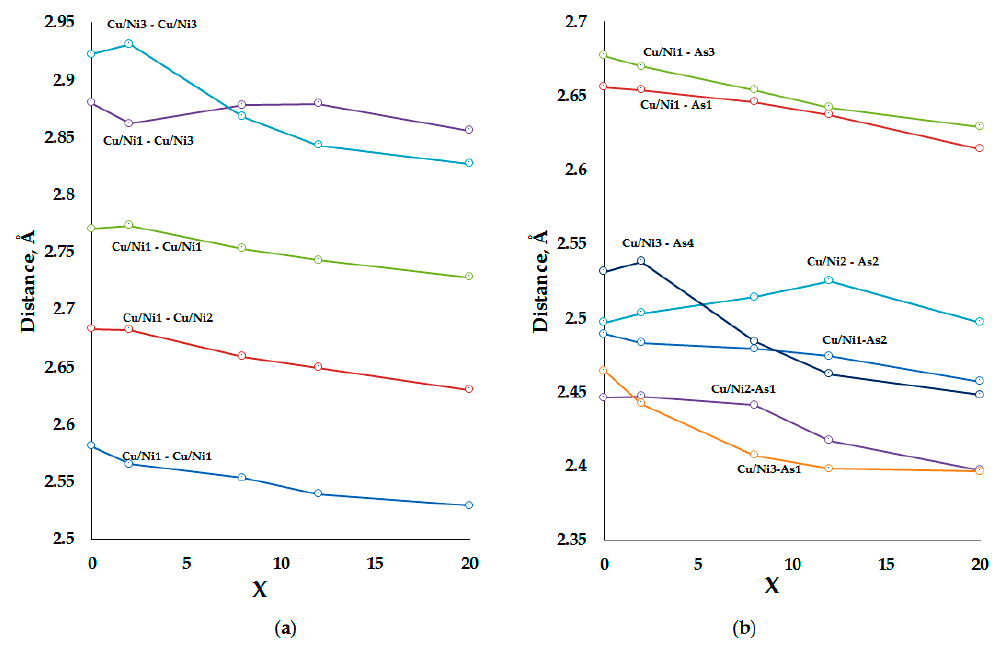
Figure 5. The ( a ) Cu/Ni–As; and ( b ) Cu/Ni–Cu/Ni distances in the structure of Eu 7 Cu 44- x Ni x As 23 for different x . Cu/Ni denotes mixed sites of Cu and Ni. The standard deviations are below the sizes of experimental datapoints. The lines are drawn to guide the eye.